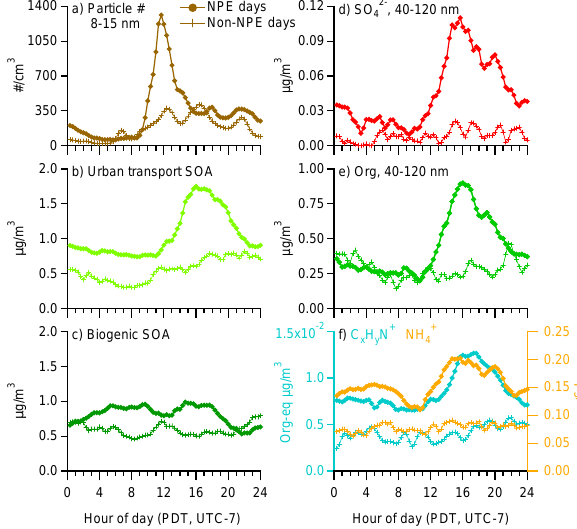
Figure 8. Diurnal patterns of (a) particle number concentration (10– 15nm), (b) urban transport SOA, (c) biogenic SOA, (d) SO 2 − 120 nm in D va ), (e) Org (40–120nm in D va ), and (f) N-containing organic ions (=CHN + +CH 4 N + +C 2 H 3 N + +C 2 H 4 N + ) and am- monium during NPE (solid symbols) and non-NPE (open symbols) days at